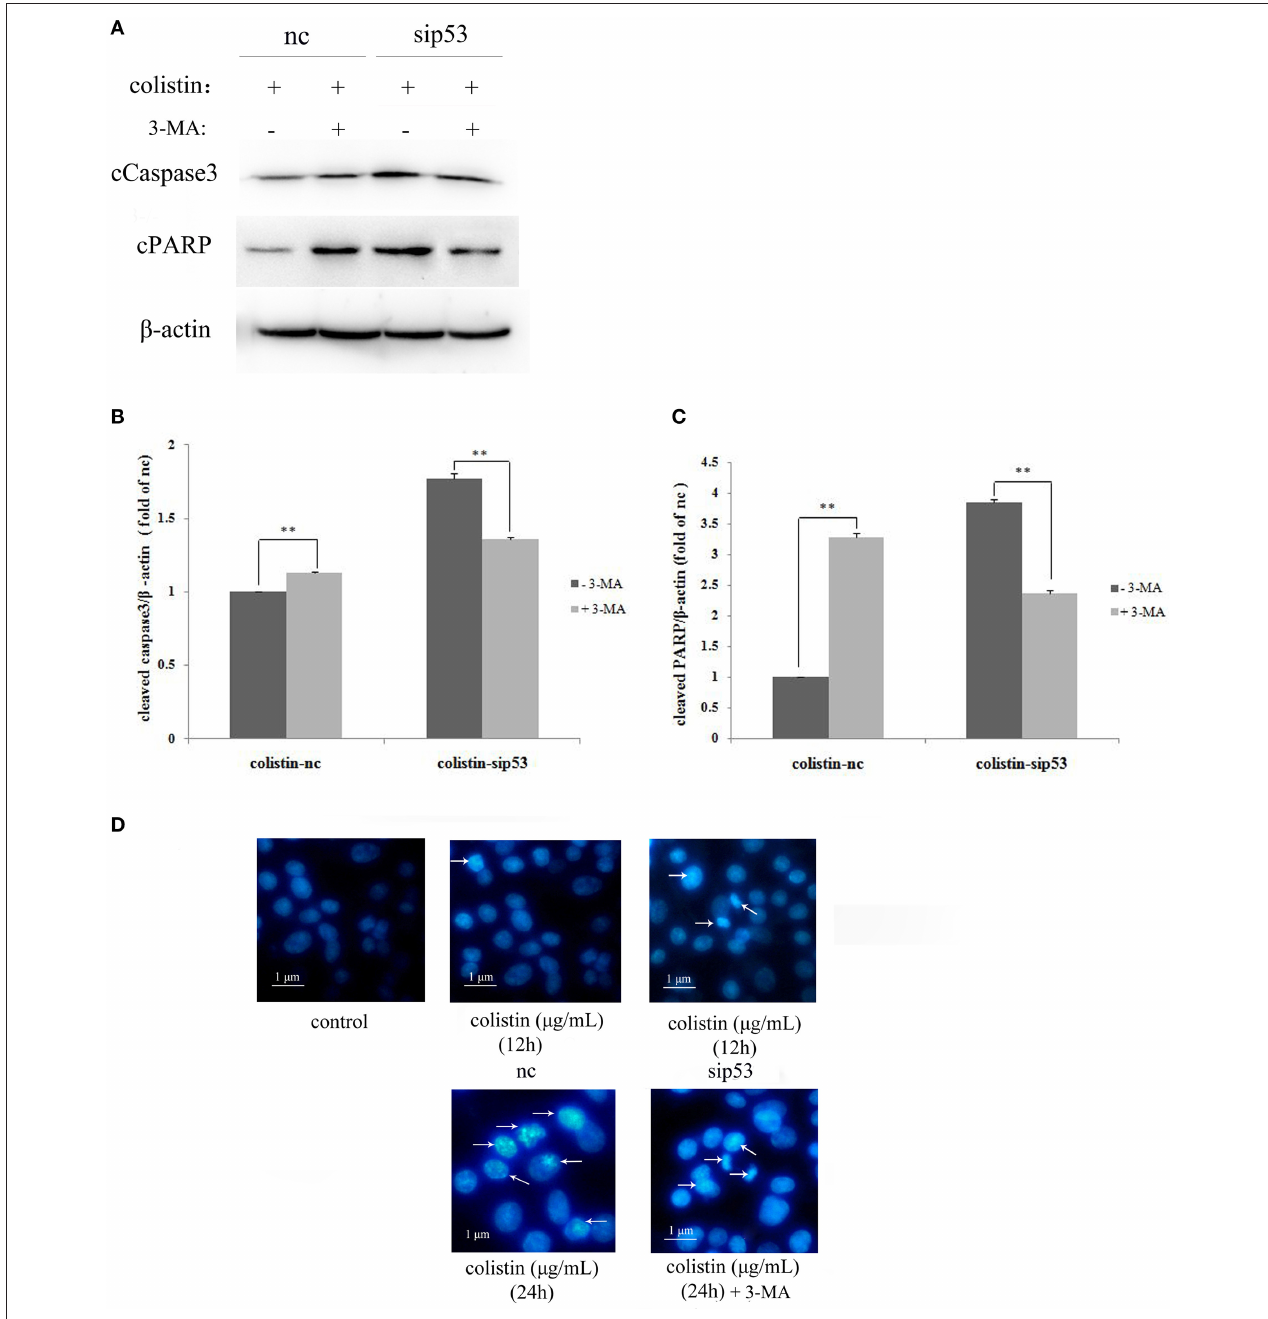
FIGURE 4 | Apoptosis induced by the impaired autophagy in PC-12-sip53 cells treated with colistin. (A–C) Lysates of PC-12 cells and PC-12-sip53 cells, untreated or treated 3-MA for 1h and further treated with colistin (125 µ g/mL) at 12h, and then western blot assaying on the levels of cleaved caspase3 and PARP. The β -actin level was used as the internal standard. Bar graph represents the mean percentage ± SD , whereas n = 3. ** p < 0.01 vs. control group. (D) Changes of nuclear morphology in PC-12-sip53 cells with colistin treatment for 12 and 24h, incubated with or without 3-MA by Hoechst 33258 staining. Arrows indicate fragmentation of the nuclear or